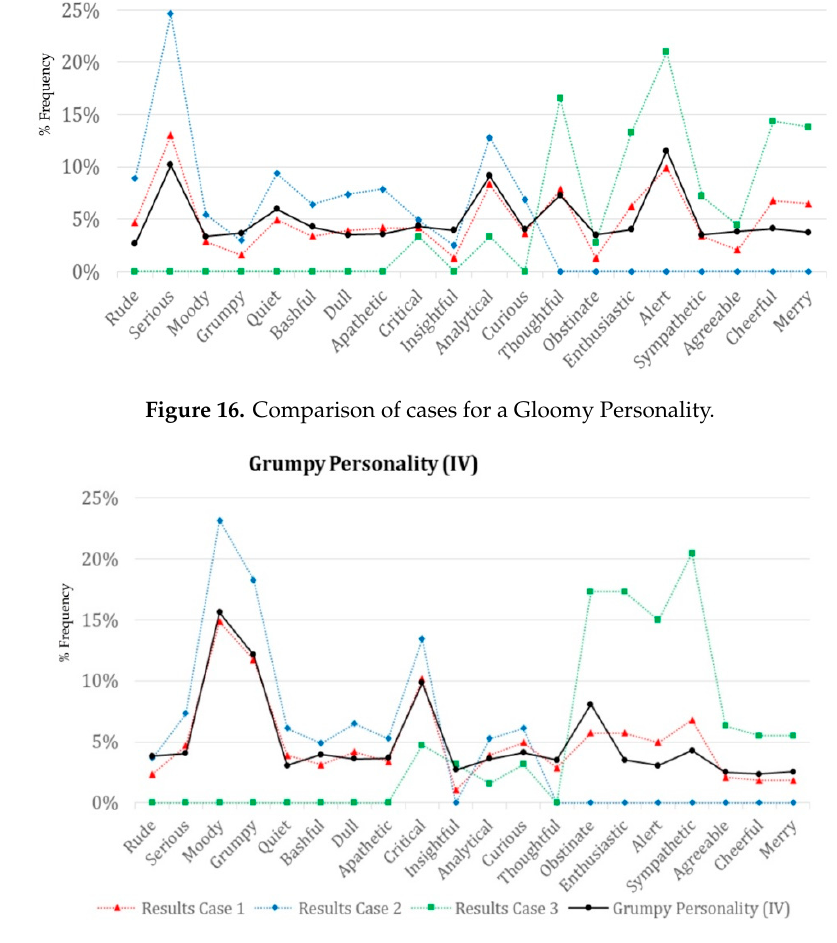
Figure 17. Comparison of cases for a Grumpy Personality.